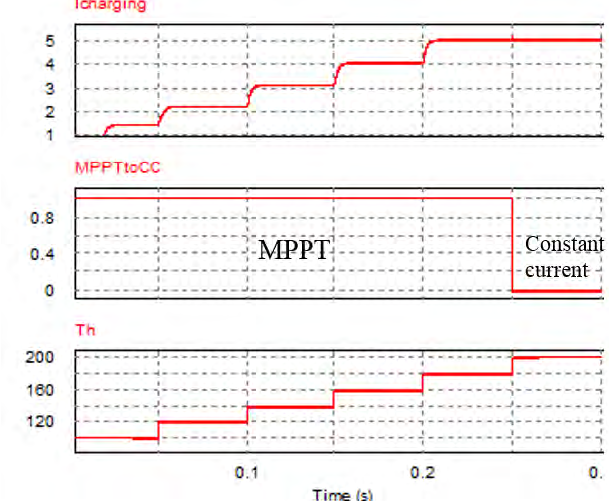
Figure 12. Output current at different hot side temperatures in the full operation range of 100 ◦ Cto 200 ◦ C during current control stage